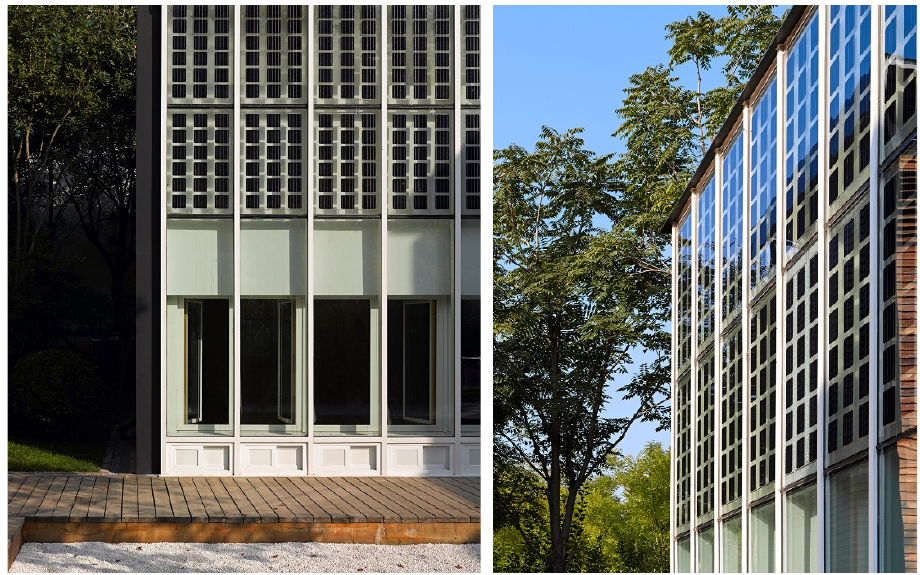
Figure 3. A photovoltaic double skin-façade in Beijing [10].